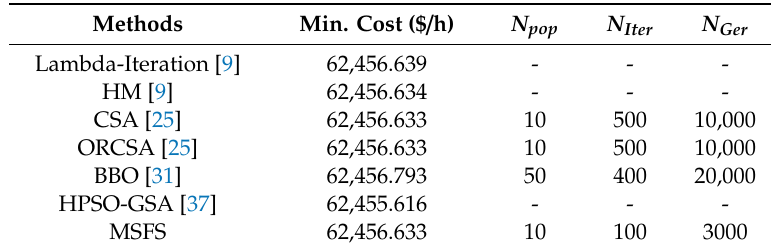
Table 11. Comparison of the implemented results for case